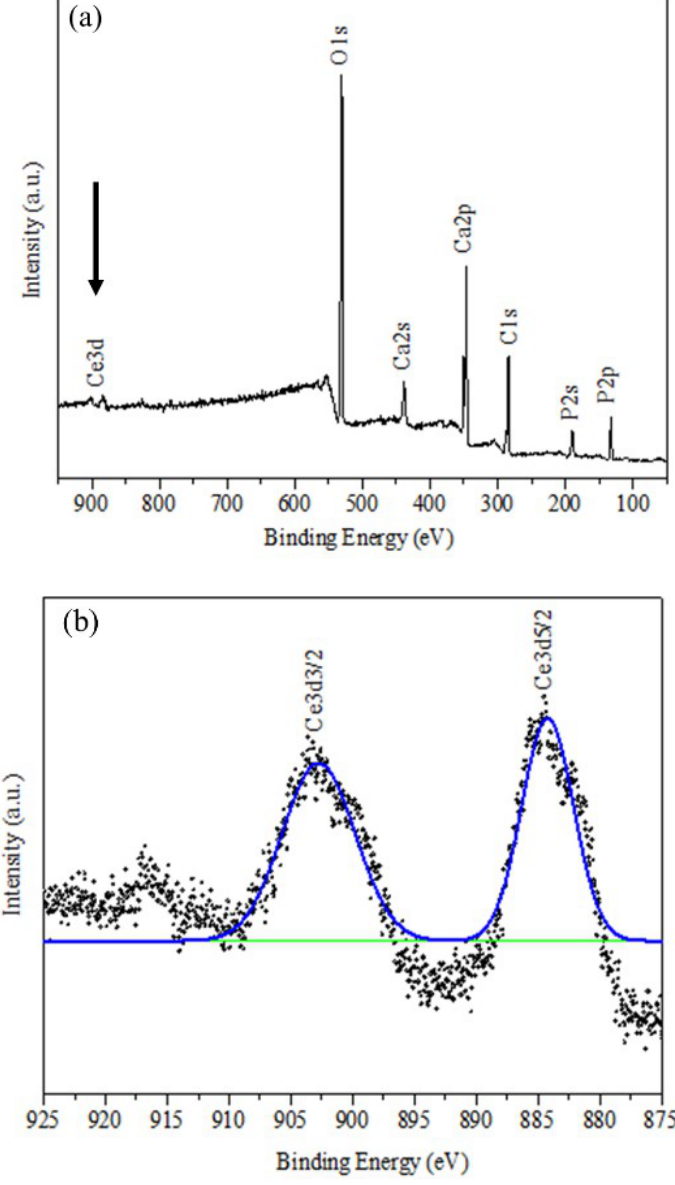
Figure 5. XPS spectrum for ( a ) Ce-HAp and ( b ) binding energy (B.E) corresponding to the 3d5/2 and 3d3/2 pairs of spin-orbit doublets.